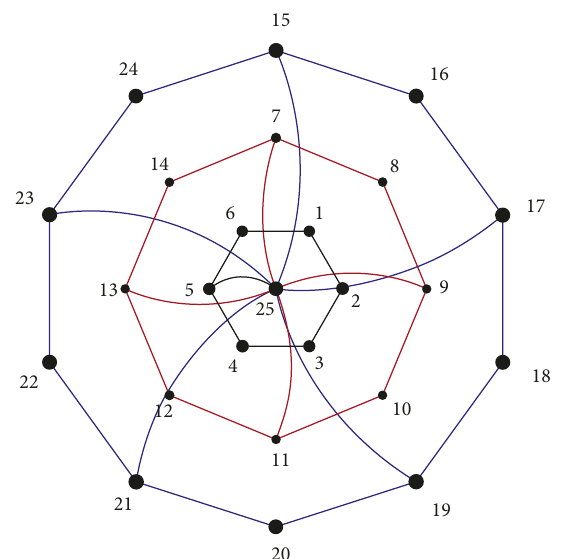
Figure 1: Graph of I